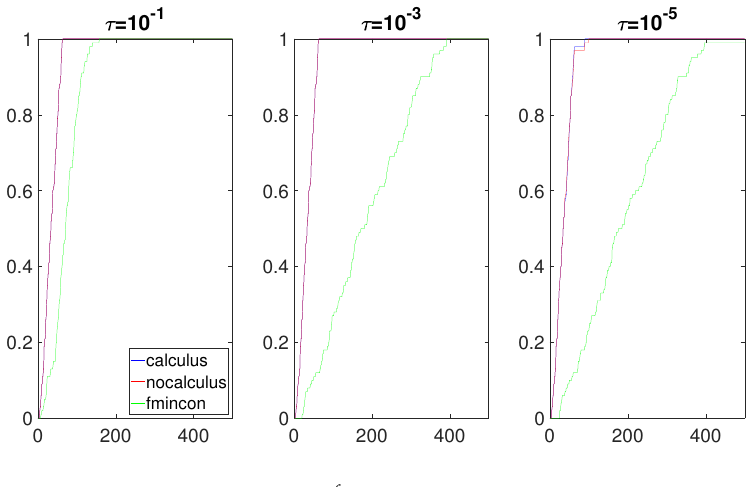
, f 1 is a quadratic function, and f 2 is a linear function. f 2